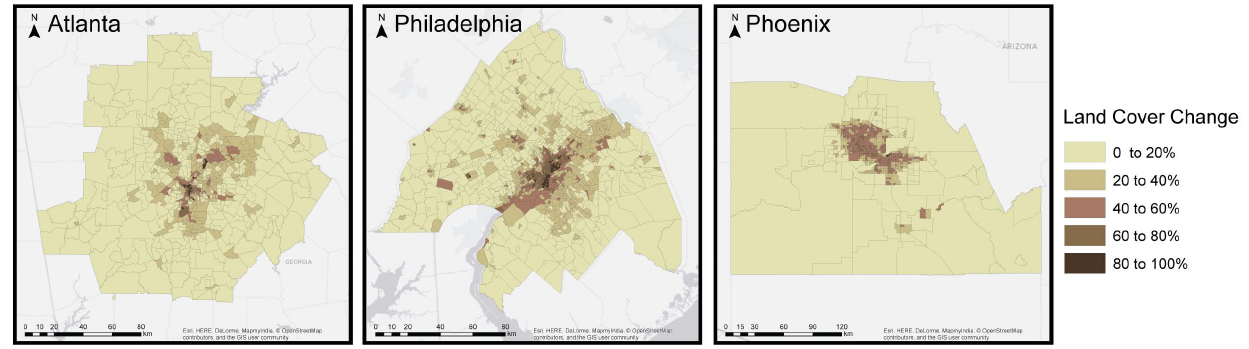
Figure 2. Percent of census tract area modified through the ALL heat management scenario . Land cover changes include the addition of new tree canopy, grass, or shrubs; conversion of roofing areas to greenroofs or high albedo materials; and the conversion of streets and other surface paving to moderate albedo materials (see Table 1).